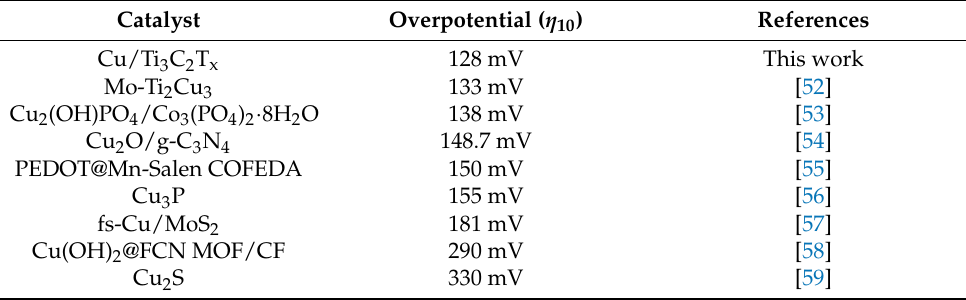
Table 1. The overpotential of non-precious metal-based HER catalysts. Catalyst Overpotential ( η 10